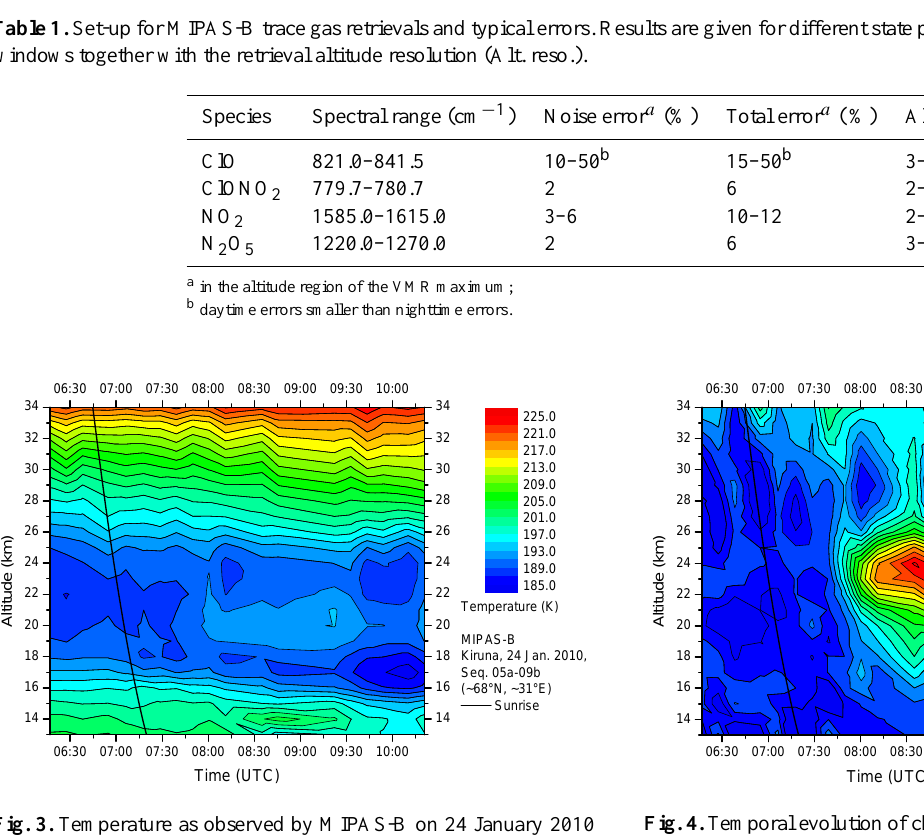
Fig. 3. Temperature as observed by MIPAS-B on 24 January 2010 above northern Scandinavia between 06:16 UTC and 10:20 UTC inside the Arctic vortex within the longitude / latitude sector shown in Fig. 1. The black solid line marks the sunrise terminator. Temperatures of less than 191 K occurred over a wide altitude region between about 16 and 26 km.